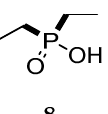
Figure 7. Chemical structure of 8 .